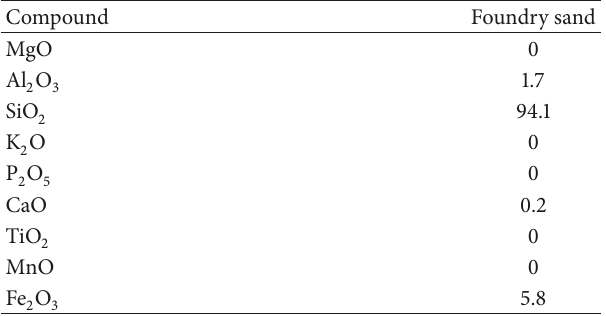
Table 1: Chemical and mineral composition of cement and silica fume.